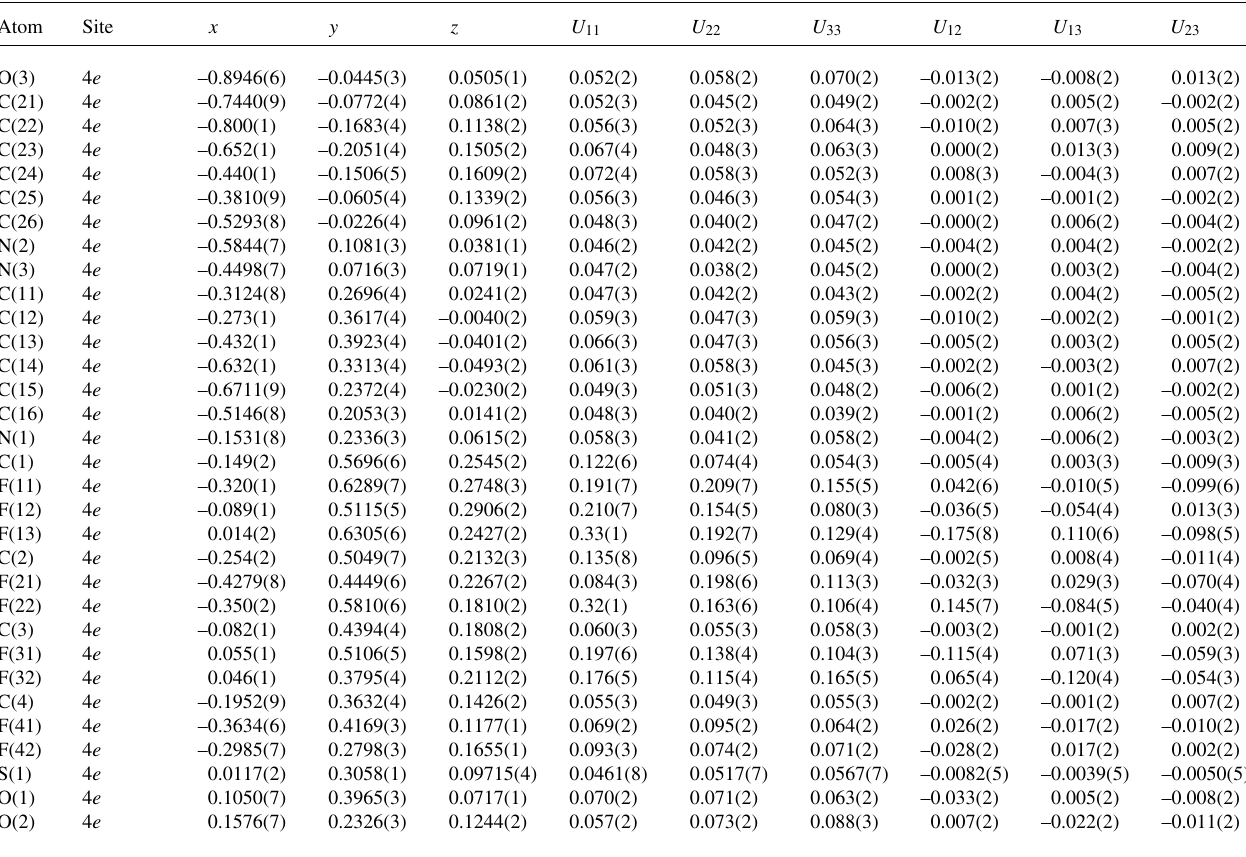
Table 3. Atomic coordinates and displacement parameters (in Å 2 )